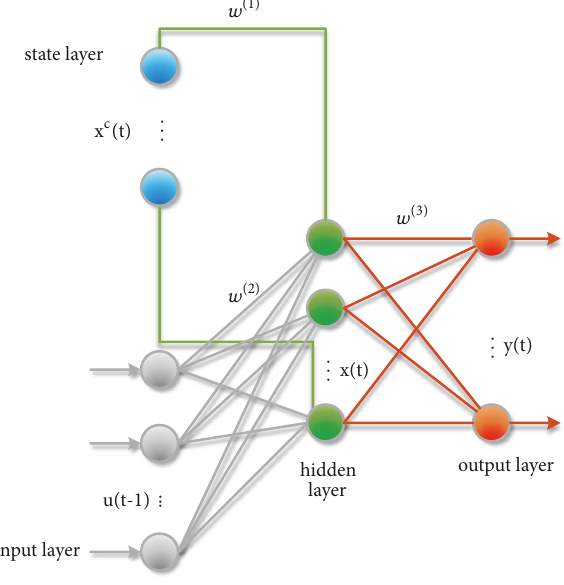
Figure 2: Recurrent neural network